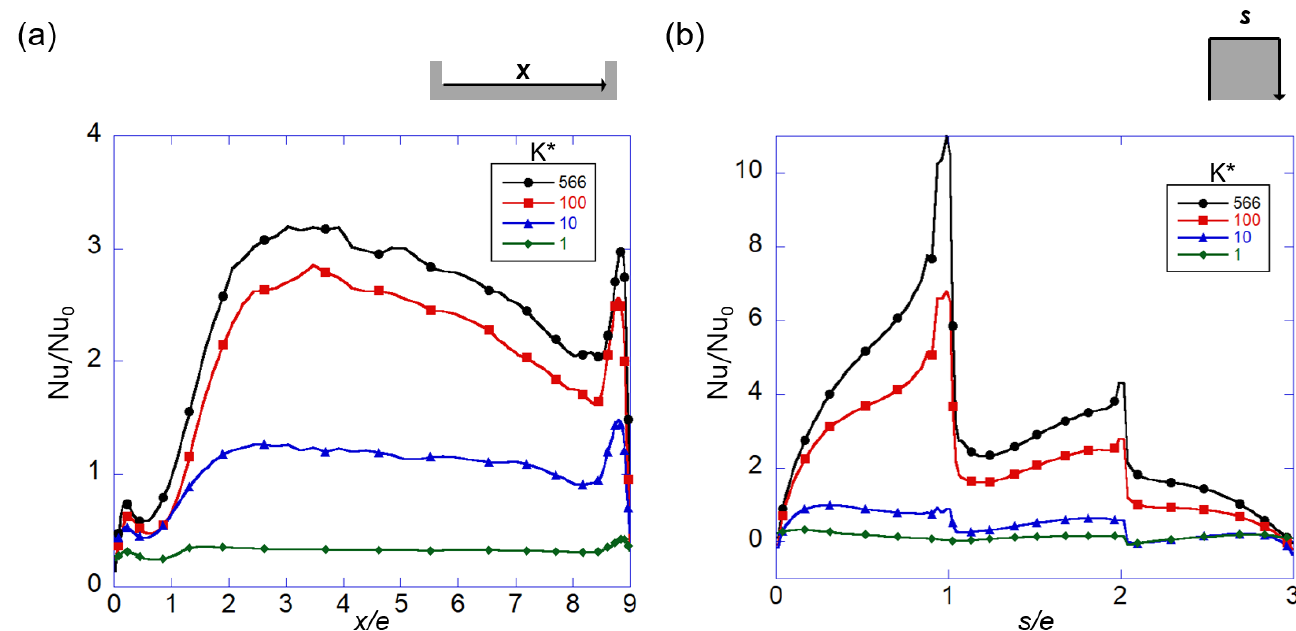
Figure 6. Effect of thermal resistance on local convective heat transfer along the solid–fluid interface: ( a ) heat transfer along the interface between the ribs and ( b ) heat transfer on the rib.